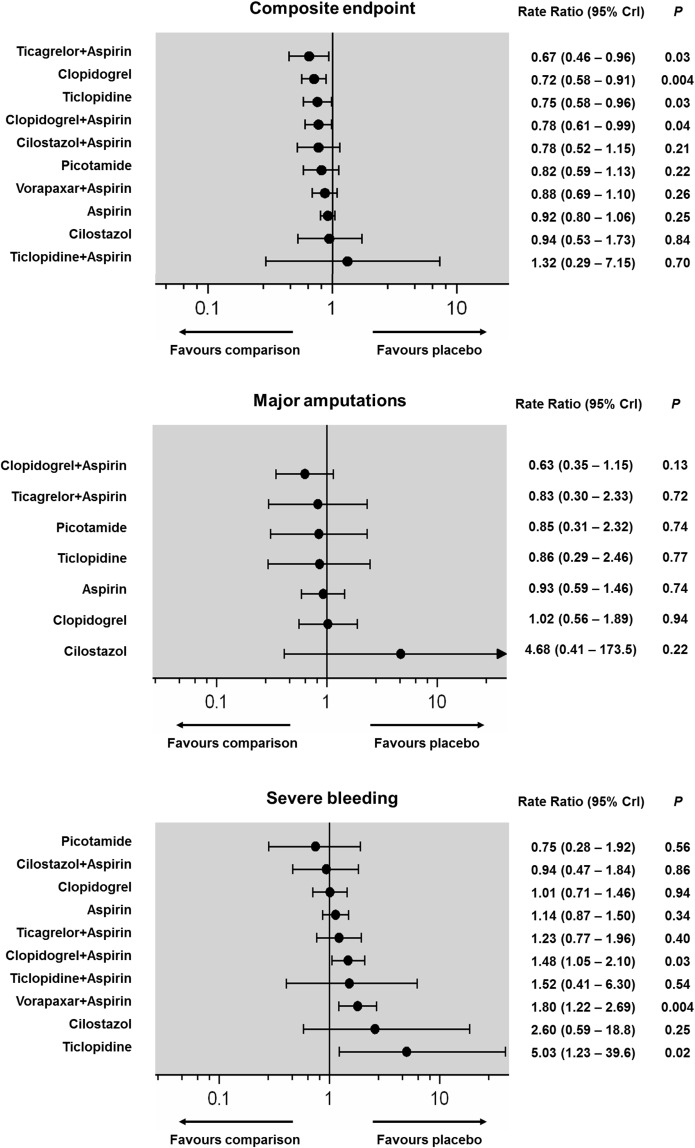
Pooled estimates for the MACE composite endpoint, major leg amputations and severe bleeding (Fixed effects forest plot).Antiplatelets are reported in order of efficacy or safety ranking. Black circles denote the posterior median and the black lines denote the associated 95% CrI. Numbers represent rate ratios (RR) and 95% CrIs. P values were approximated by the two-tailed posterior probabilities.